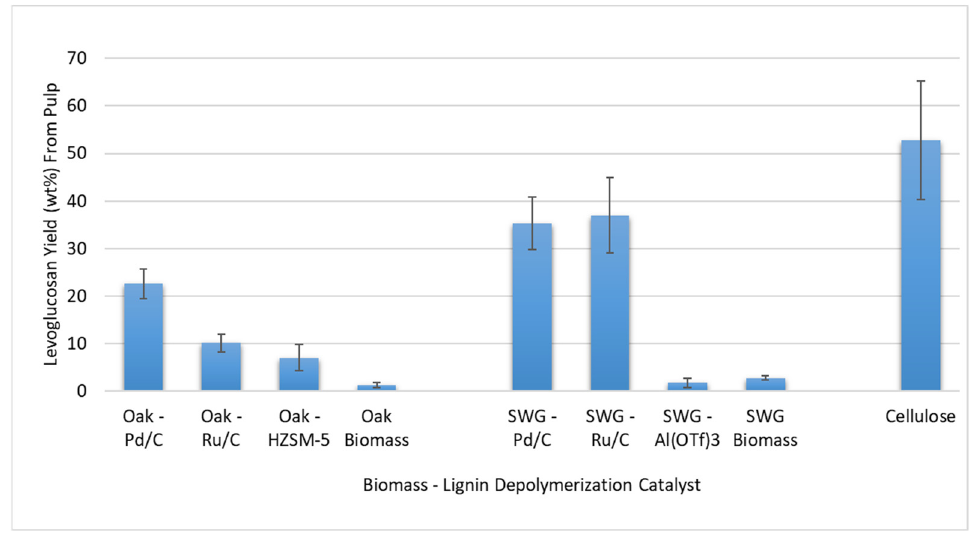
Figure 4. Levoglucosan yield (wt %) from pyrolysis of cellulosic pulps isolated after lignin-first fractionation in ethanol at 210 °C. Pyrolysis at 550 °C. Error bars are one standard deviation.